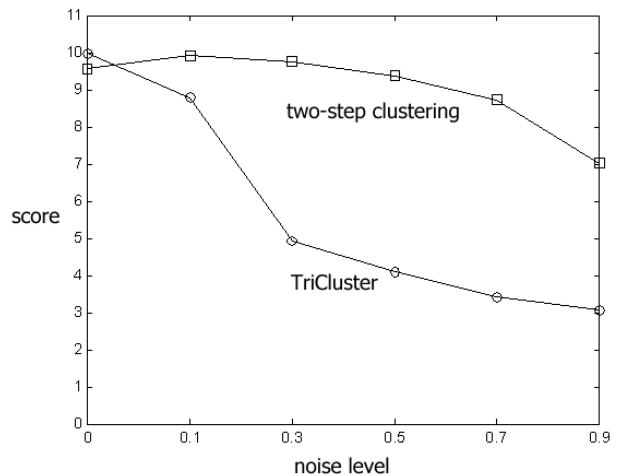
Figure 1: Results from the evaluation on artificial data. The plot shows the scores obtained at different noise levels ranging from σ = 0 (clear signal) to σ = 0 . 9 (distorted signal). In case all 10 modules are found without additional or missing genes, the optimal score of S=10 can be